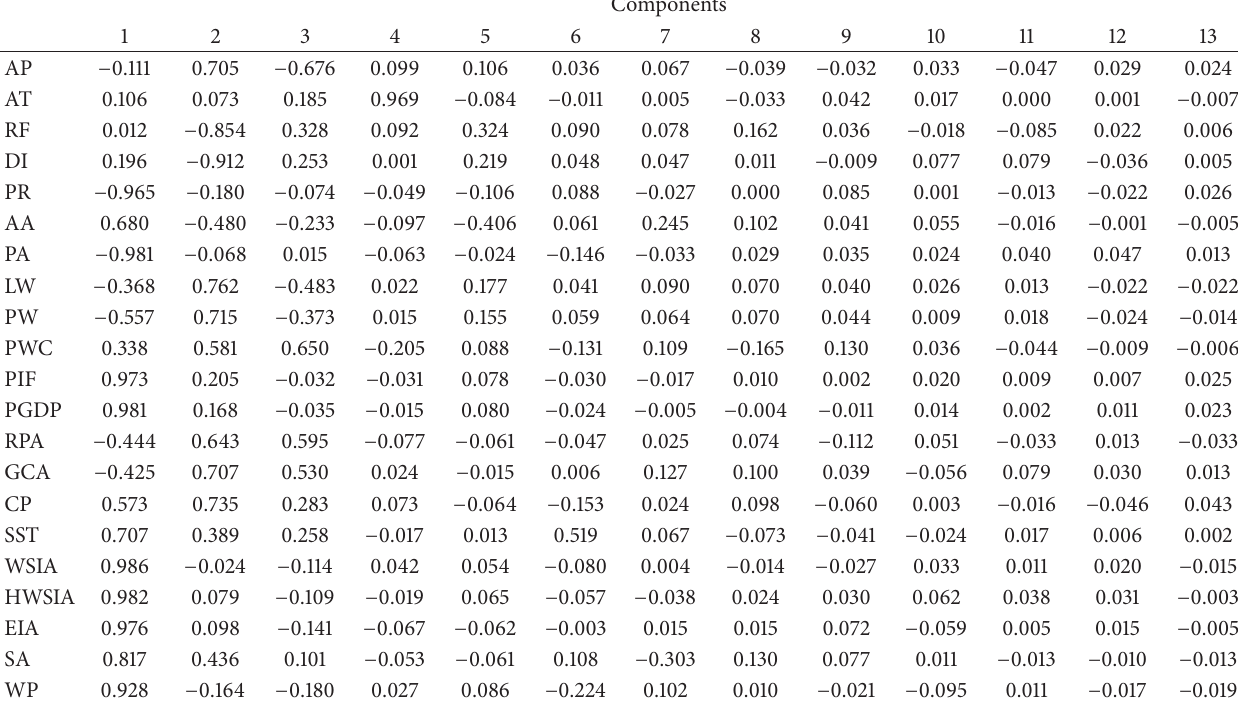
Table 5: Principal components score coefficient matrix.